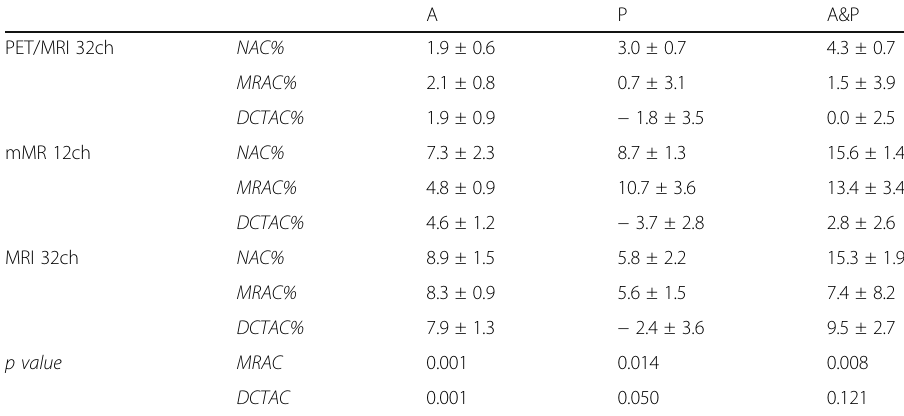
Table 1 RPD of the global means for each case A, P and A&P; NAC, reconstructed with MRAC and DCTAC. The negative value represents over-correction of attenuation A P A&P PET/MRI 32ch